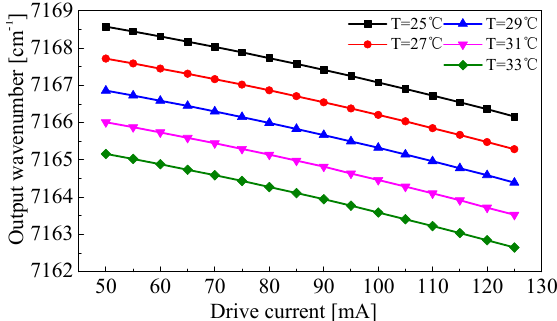
Figure 8. The relationship of the output wave number and the laser drive current at different operation temperatures. Appl. Sci. 2017 , 7 , 990